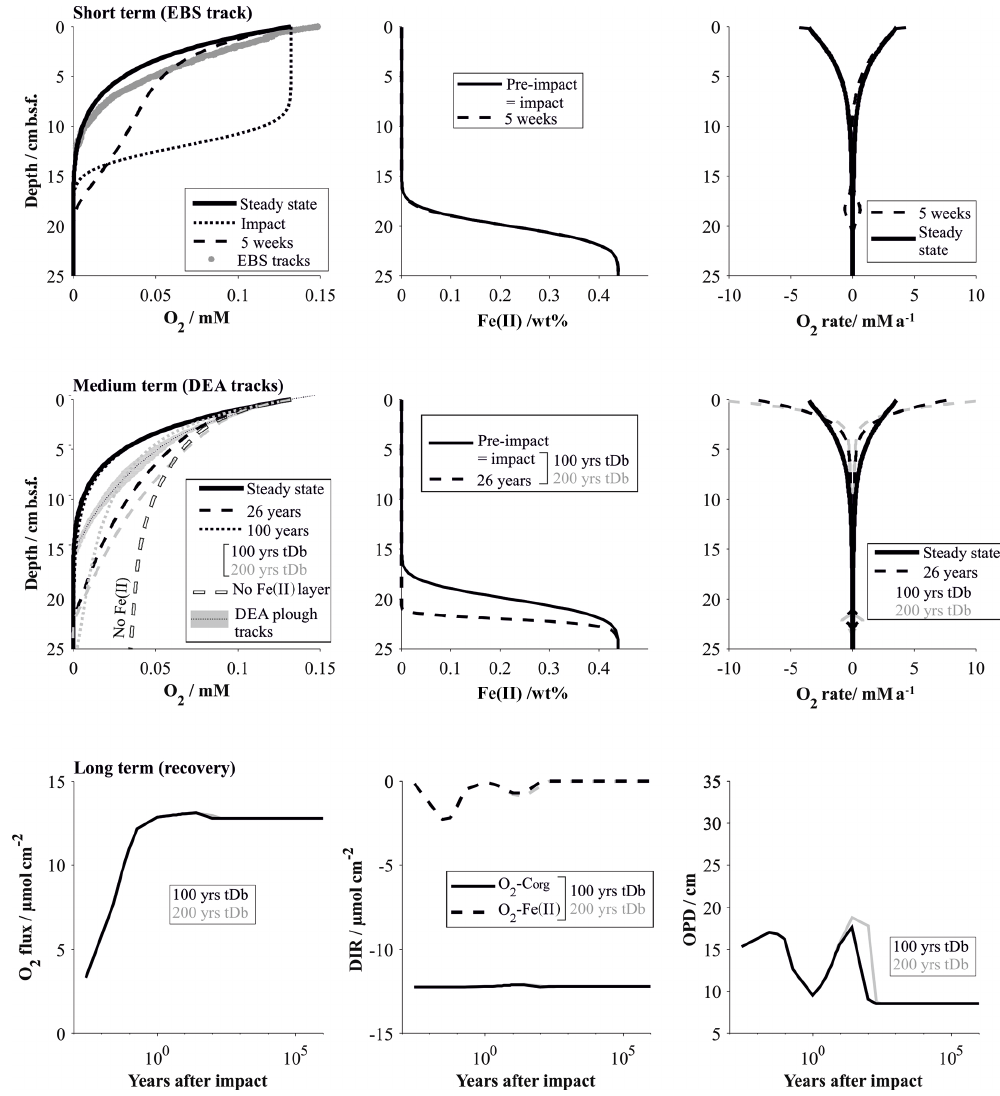
Figure 11. Impact simulations after a disturbance causing the upper sediment layer to be exposed to bottom water oxygen levels (i.e. through mixing or by resettling sediments; see Fig. 9). See the caption of Fig. 10 for